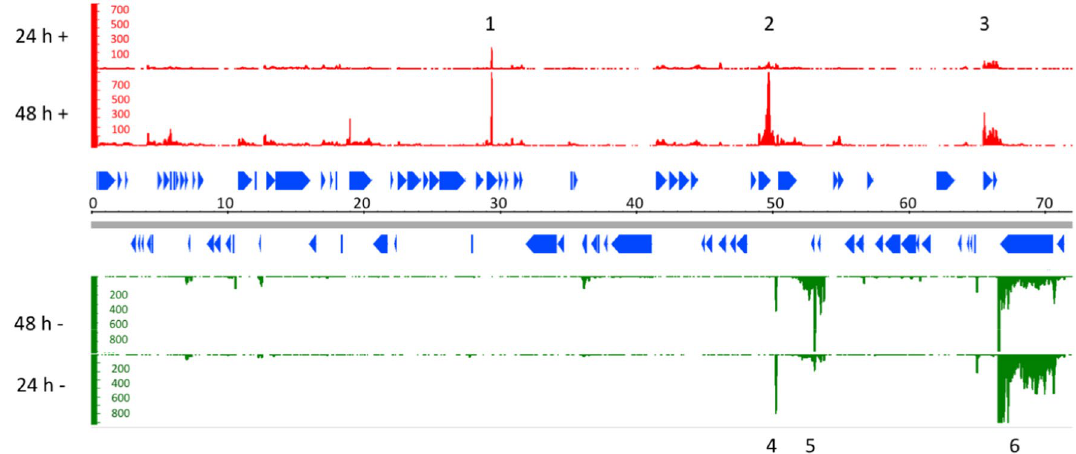
Figure 1. Transcriptome of the tent -containing 74 kb plasmid in C. tetani strain A when grown under anaerobic conditions in TGY medium for 24 and 48 h. RNA-seq data was mapped to the plus and minus strand of the 74 kb reference plasmid; the nucleotide position is given in kb (grey bar). The blue triangles indicate coding sequences. Peaks of high transcription are labelled: 1, CTP27 (encoding a putative 23S rRNA (guanine-N1) methyltransferase); 2, CTP44 (gene of unknown function); 3, CTP58/CTP59 (genes of unknown function); 4, intergenic region between CTP44 and CTP45 (the latter encodes a putative replication protein); 5, CTP46 and CTP47 (genes of unknown function); 6, tent gene (CTP60). The image was created with the Integrative Genome Browser (IGB v8.5.4; https ://biovi